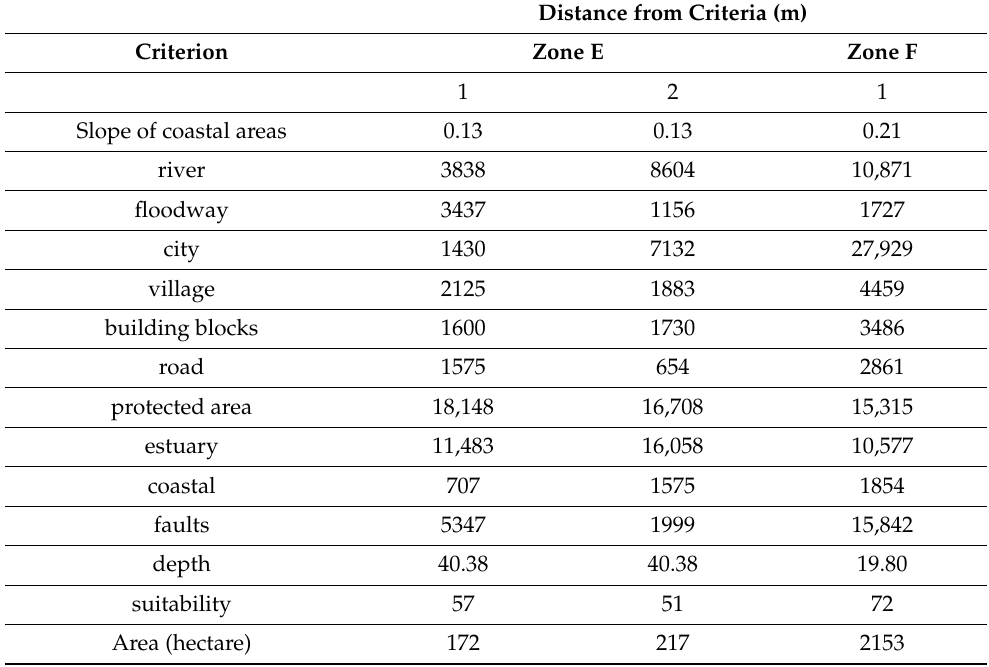
Table 5. The average suitability of the criteria in the central part of the region. Distance from Criteria (m) Criterion Zone E Zone F 1 2 Slope of coastal areas